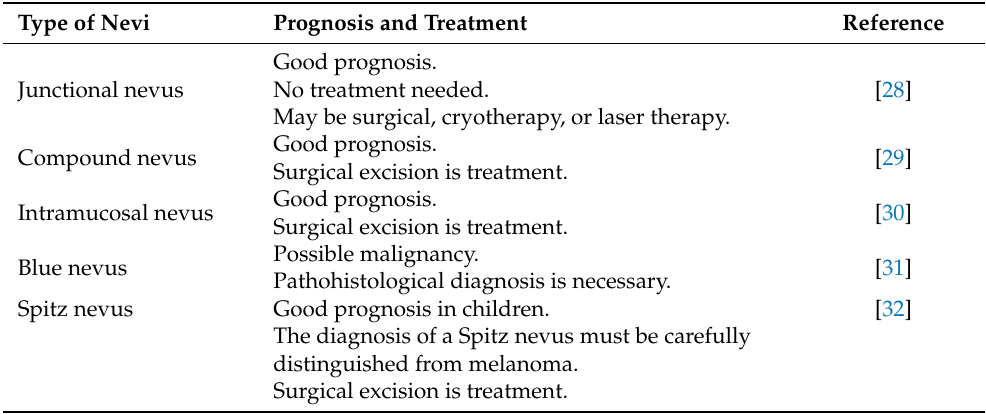
Table 1. Prognosis and treatment according to histological type of nevi. Type of Nevi Prognosis and Treatment